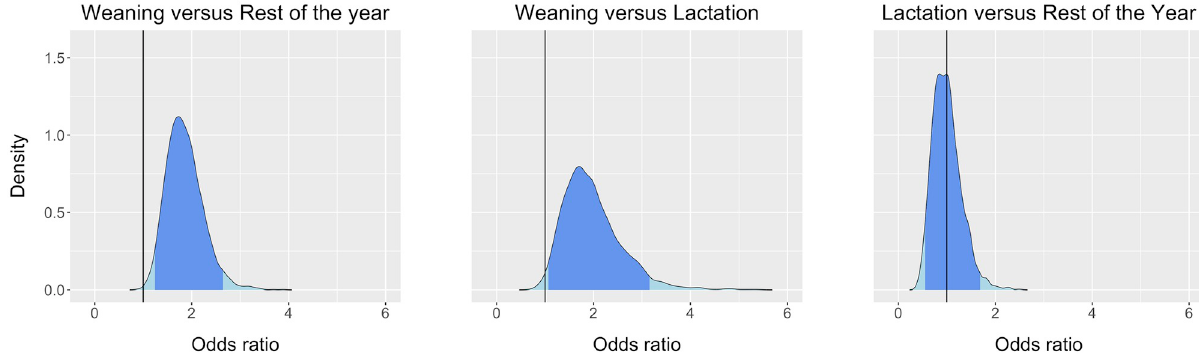
Fig 3. The Posterior Probability Distributions (light blue) and the corresponding 95% Highest Posterior Density Interval (blue) of the odds ratio for coronavirus shedding by Eidolon helvum in the roost at Morogoro Tanzania during the “weaning” period versus the “rest of the year”, during the “weaning” period versus the “lactation” period, and during the “lactation” period versus the “rest of the year”. The vertical black line indicates a neutral odds ratio with a value of